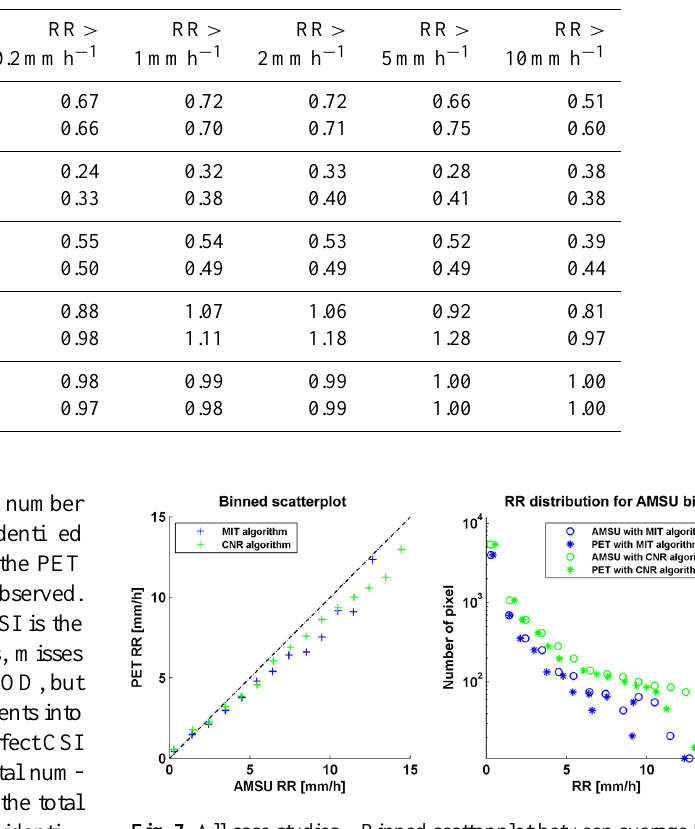
Fig. 7. All case studies – Binned scatter plot between average PET rain field estimates and 1mmh − 1 AMSU rain field estimates bins, using both MIT and IMAA-CNR algorithm with the corresponding RR